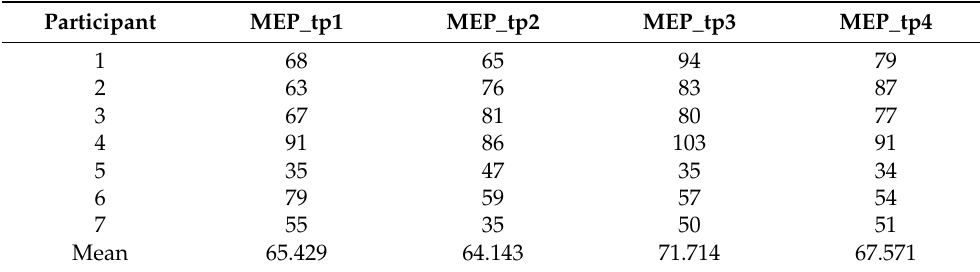
Table 5. MEP (cm H 2 O) individual and mean measurements at four assessment time points.